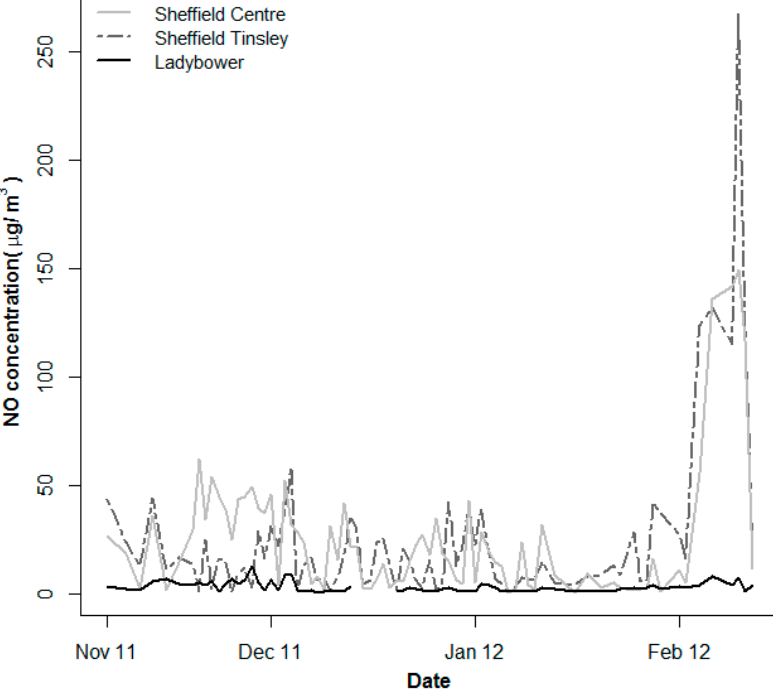
Figure 3. NO concentrations for the three monitoring stations around Sheffield city over the study period November 2011–February 2012.